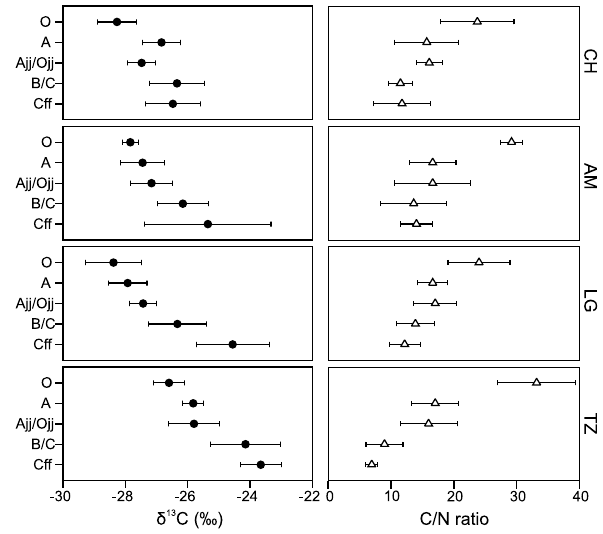
Figure 4. Vertical pattern of δ 13 C values and C / N ratios of bulk soils with respect to different sampling sites and soil horizon clus- ters (mean ± SD; n is given in Table